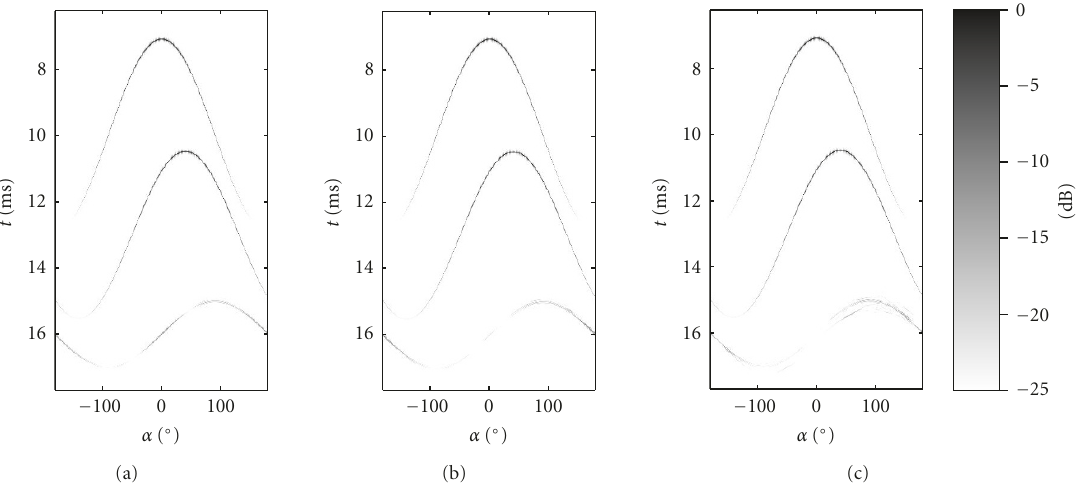
Figure 8: Results of subtracting the reconstructed response of the wave with elevation angle θ = 70 ◦ from the data set of Figure 3, after selecting the data in the model space using filter windows “a,” “b,” and “c” (indicated in Figure 6),